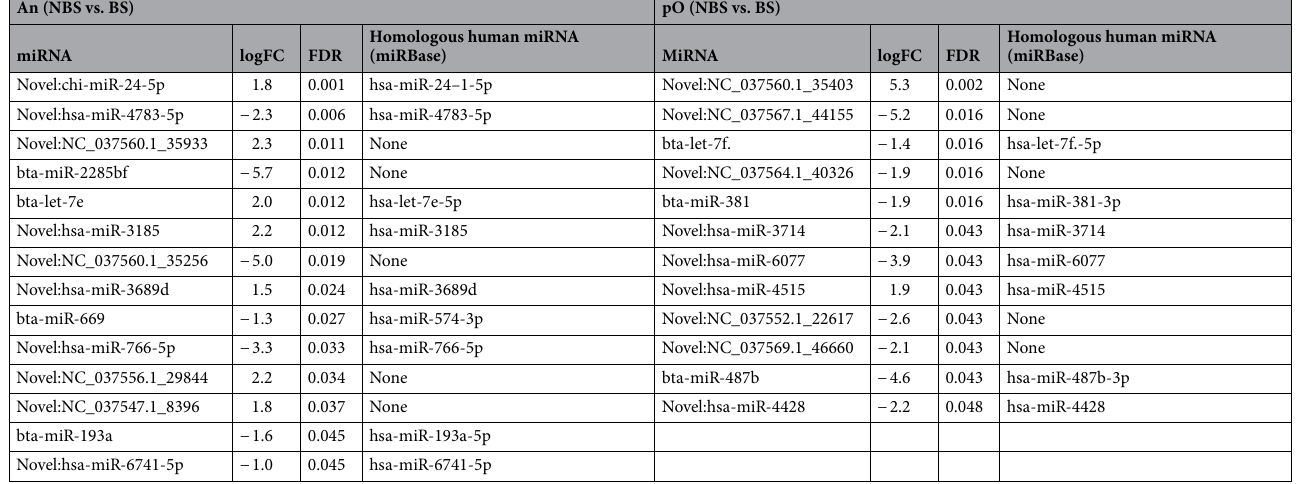
Table 3. Differentially expressed miRNAs (DE-miRNAs) between non-breeding (NBS) and breeding season (BS) in antral (An) and preovulatory (pO) follicles. For each DEmiRNAs, logFC = log Fold Change, False Discovery Rate FDR < 0.05 and homologous human miRNA were